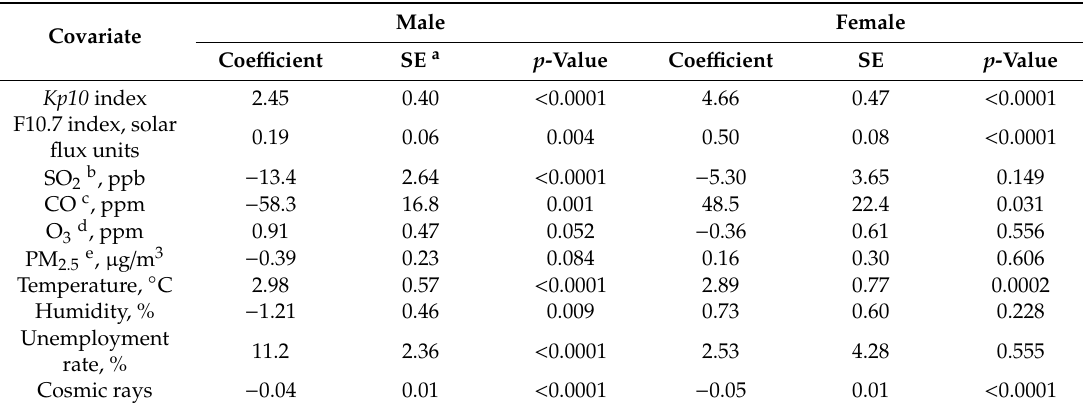
Table 3. Results of the univariate linear regression analysis.